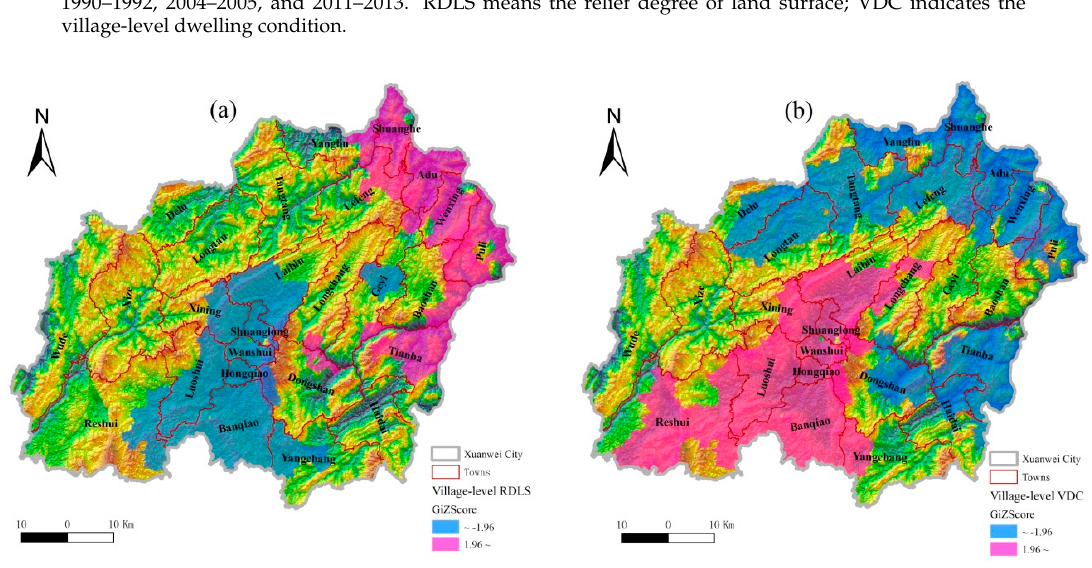
Figure 3. Spatial clustering of the village-level RDLS ( a ) and VDC ( b ). RDLS and VDC denote the relief degree of land surface and the dwelling condition, respectively.